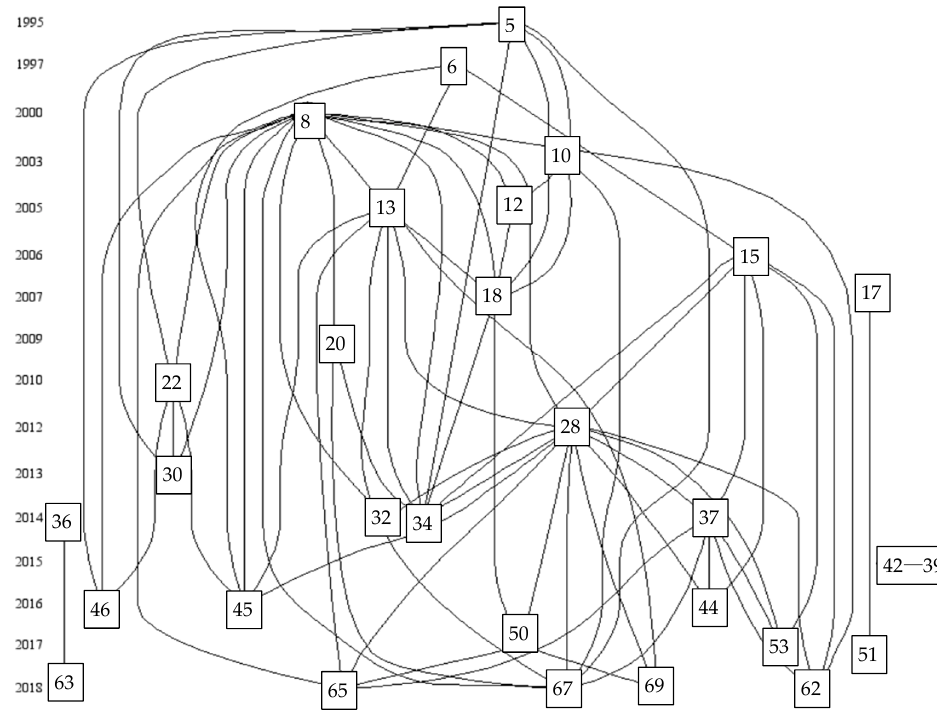
Figure 3. The research context of the relationship between leadership and envy (the graph is automatically generated by the software).